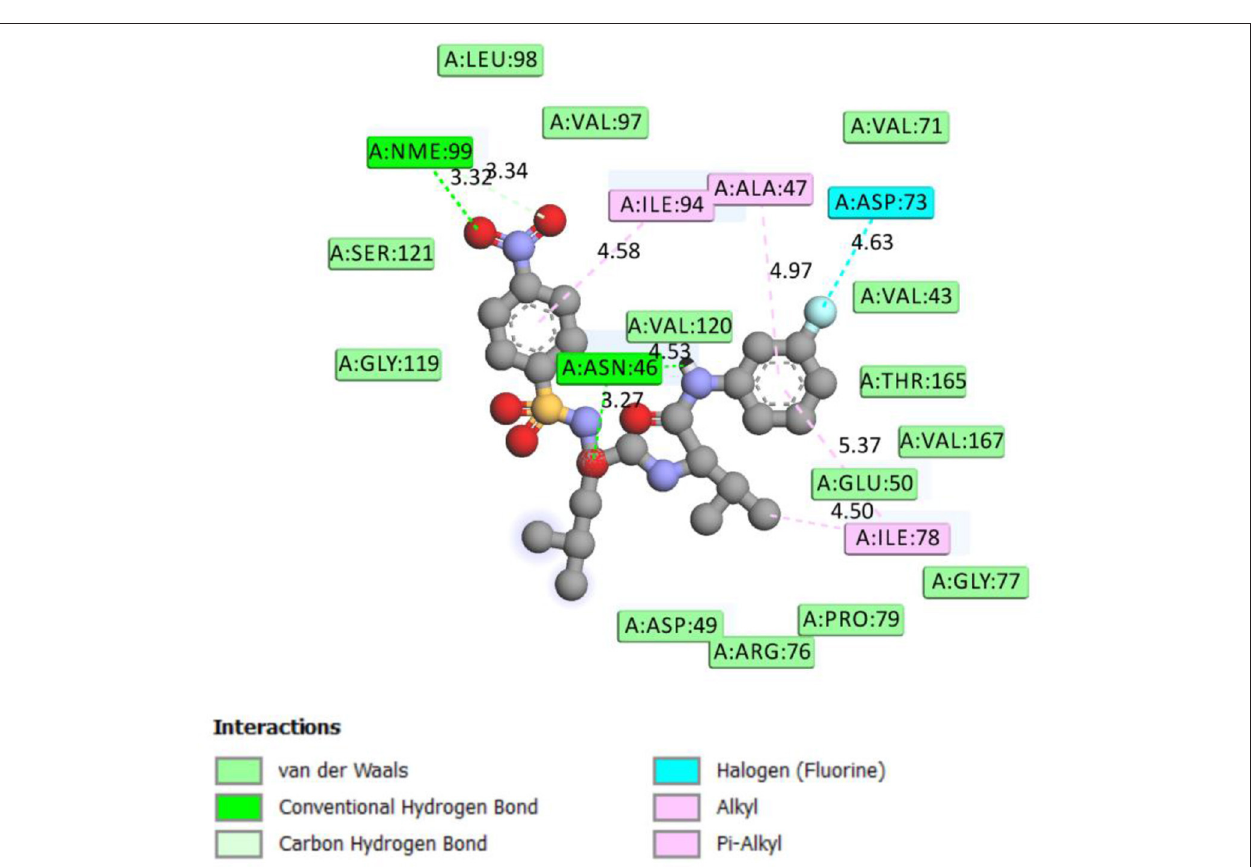
2H,Ar-H), 7.31 (t, J = 7.8 Hz, 2H, Ar-H), 7.26 (d, J = 8.0